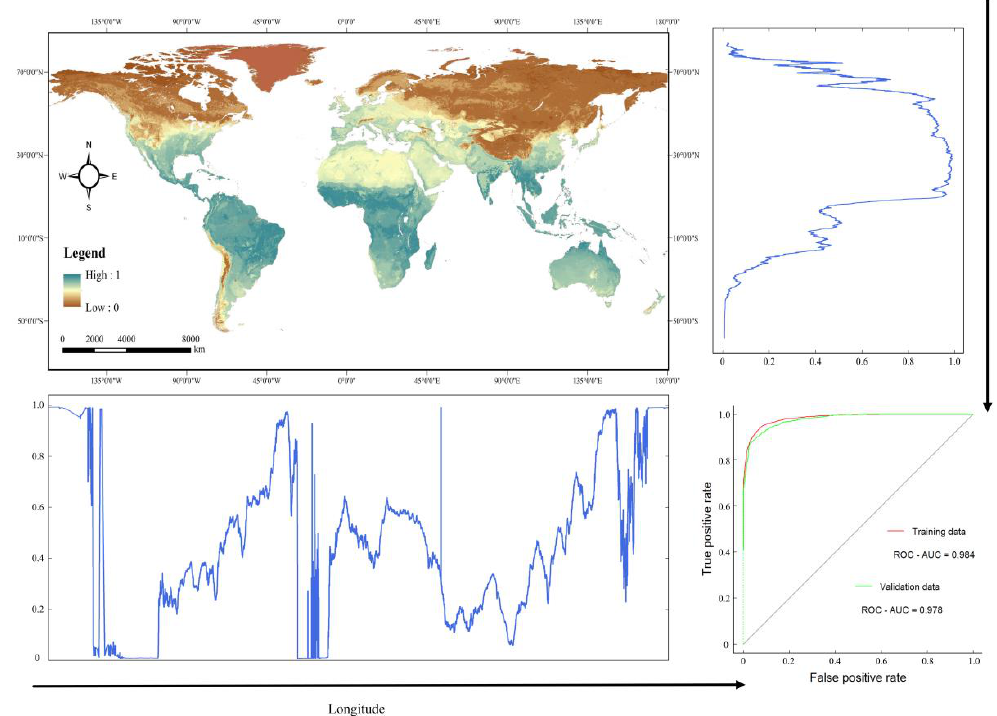
Figure 2. The global map of the predicted potential distribution of sweet sorghum. The map depicts environmental suitability for sweet sorghum from 0 (brown) to 1 (bluish green). ROC: receiver operating characteristic; AUC: area under the ROC curve.